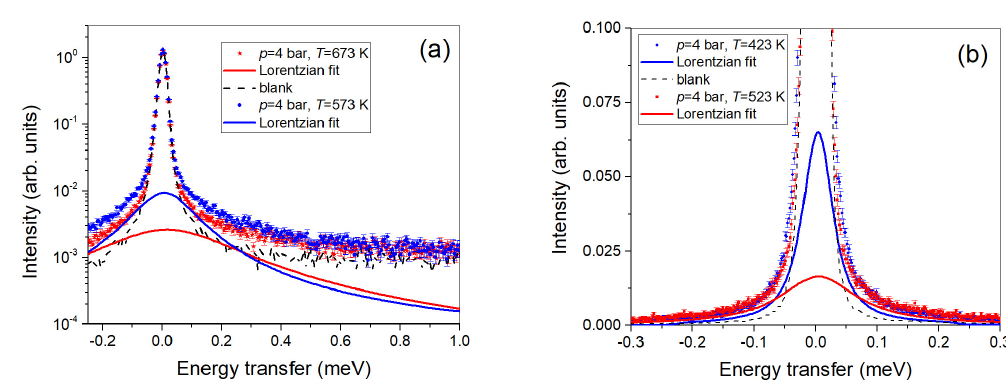
Figure 2. ( a ) spectra for the two highest temperatures at Q = 1.0 Å − 1 . The intensity scale is logarithmic to enhance the small quasi-elastic signal compared to the strong elastic scattering from the stainless-steel cell, which is included as a dashed line. The full lines show the fitted quasi-elastic contributions; ( b ) Spectra at Q = 1.0 Å − 1 are shown on a linear scale at the two lowest temperatures. The signals of the blank and the fitted quasi-elastic contributions from hydrogen diffusion are also included.